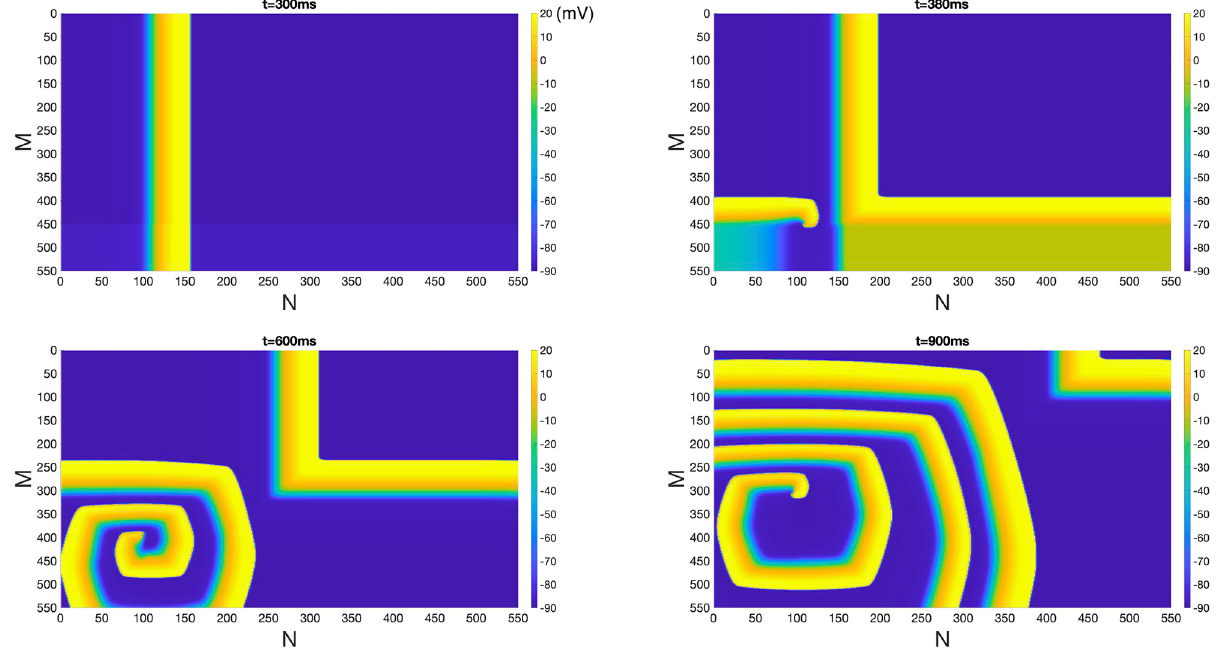
Fig 4. Reentry generated in a poorly coupled tissue in the absence of EpC. Reentry generated in 2D tissue of low gap junctions (1% of gap junctional coupling remains) of 550 by 550 cells in the absence of EpC. Colorbar indicates V m (in the units of mV). Snapshots of V m at time = 300 ms, 380 ms, 600 ms and 900 ms are